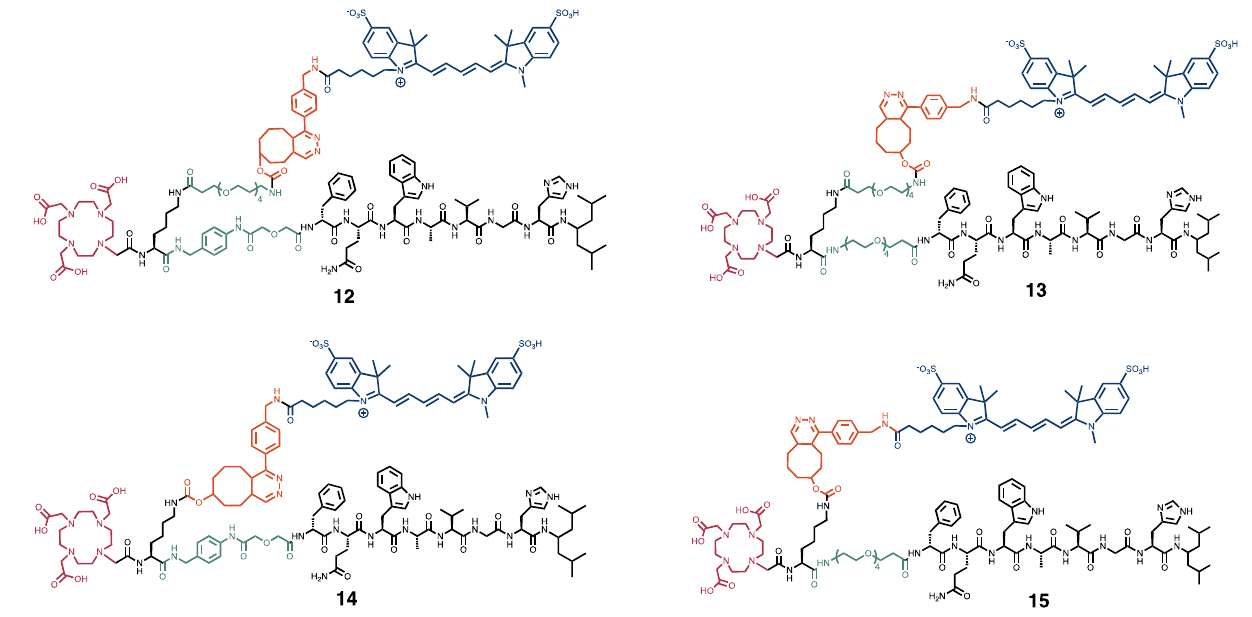
Figure 1. Chemical structures of the four dual-modality probes 12 - 15 . In black, the peptide sequence responsible for binding to the GRPR, and the lysine residue. In green, the PEG 4 and p ADA linkers. In red, the DOTA chelator. In orange, the inverse electron demand Diels–Alder click reaction, and in blue, the sulfo-cyanine 5 fl uorescent dye.